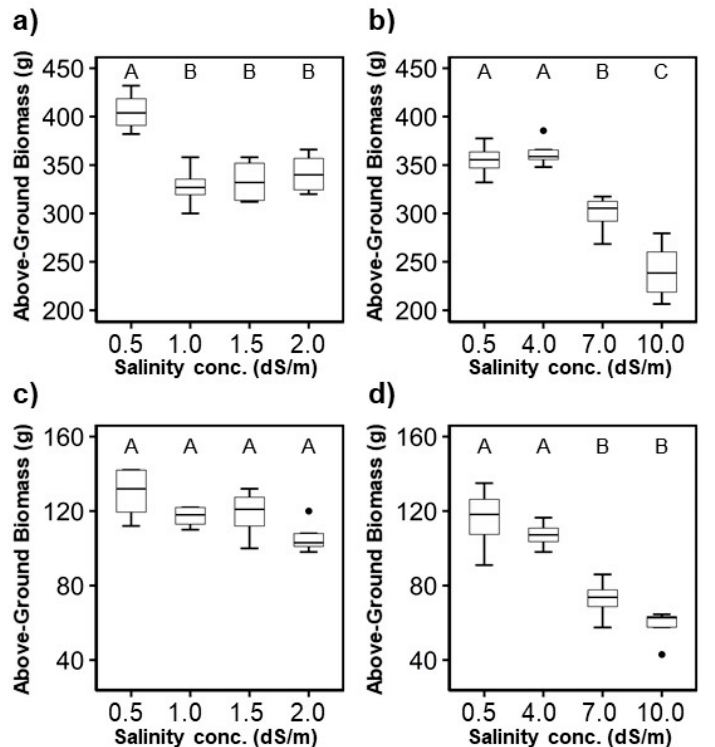
Figure 5. Variation of the above-ground biomass: ( a , b ) H. rosa-sinensis ; ( c , d ) M. splendens ; ( a , c ) first experiment; ( b , d ) second experiment. The boxplot’s height represents the interquartile range (between the 75th and 25th percentiles), and the ends of the error bars signify the maximum and minimum values. Circles beyond the error bars are outliers. The same letters in a figure indicate that treatments were not significantly different at the p < 0.05 level by Tukey’s HSD test.